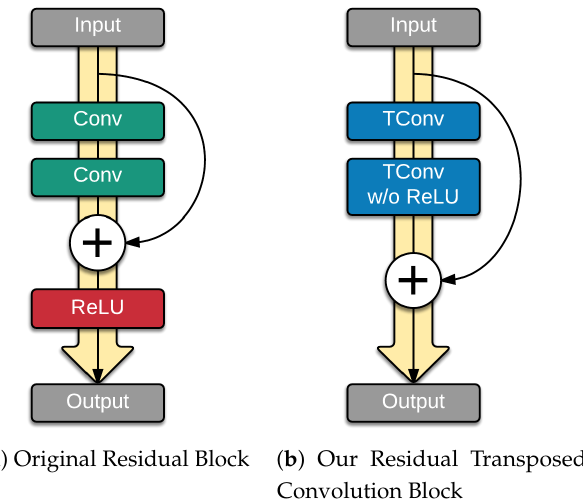
Figure 3. Difference between the original residual block and our modified residual